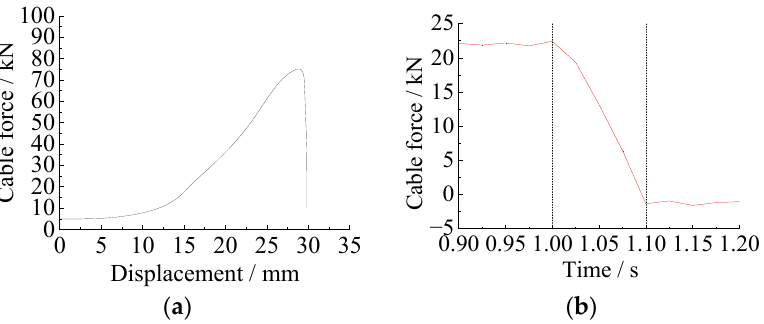
Figure 6. Feasibility test of the suspender rupture trigger device: ( a ) load–displacement curve; ( b ) suspender force ‐ break suspender time curve.